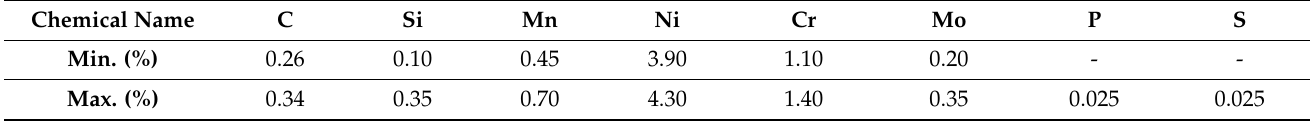
Table 1. Chemical Composition of EN-30B alloy steel (Weight %).